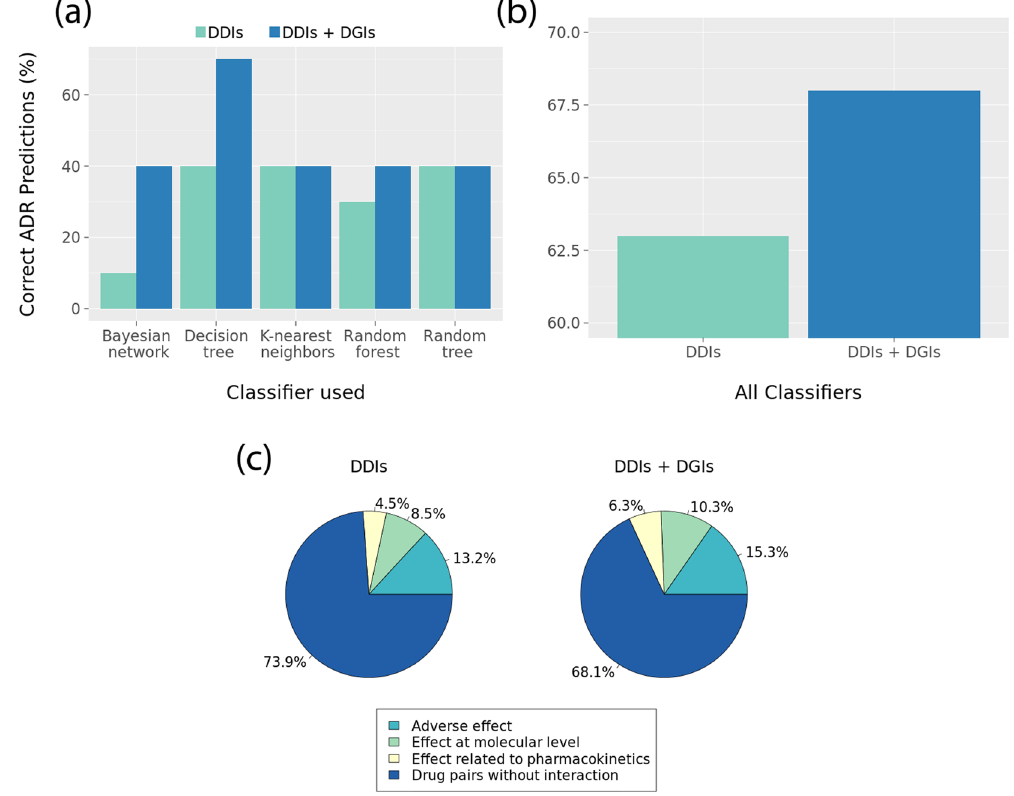
Figure 2. ( a ) Performance of classifiers to predict DDIs and ADR types; ( b ) Prediction of DDI and ADR types at least by three classifiers; ( c ) Performance of random forest classifier to predict DDIs and ADR types between NDFRT drugs suggested for cutaneous diseases and drugs using DDI features alone and DDI with DGI